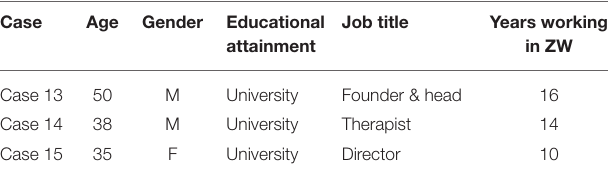
TABLE 3 | Description of research participants –